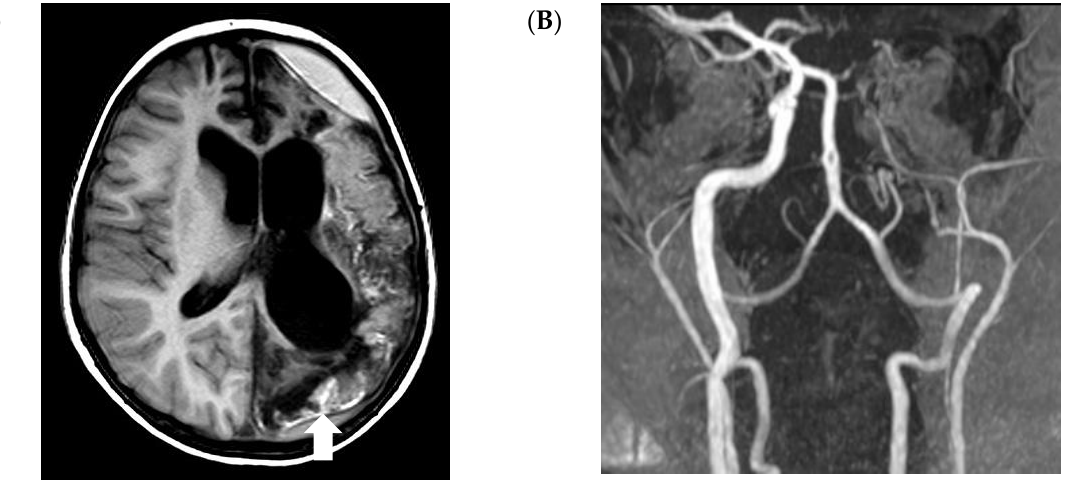
Figure 5. Vascular involvement in a 5-year-old boy with acute lymphoblastic leukemia (ALL) and probable central nervous system invasive mold infection. The patient is alive with residual right-sided hemiparesis. Magnetic resonance imaging (MRI) shows a large hemispheric infarction on the left side and cortical necrosis (arrow) on T1-W images without contrast ( A ). Time-of-flight magnetic resonance angiography (TOF-MRA) ( B ) shows only weak flow of the left internal cerebral artery.